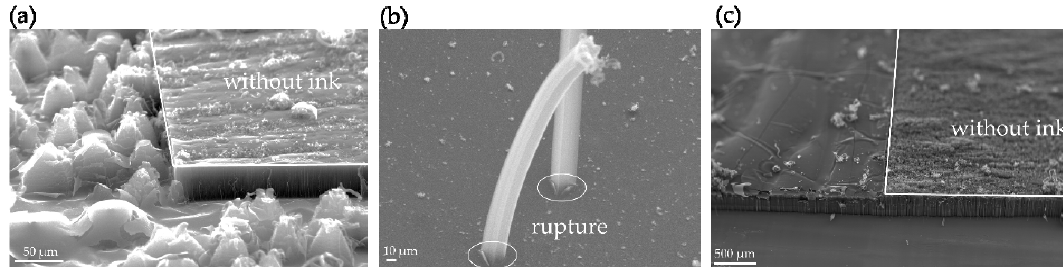
Figure 3. ( a ) A film layer forms on ink-coated areas of the sample following CNT synthesis; the resulting morphology contrasts to the areas without ink. ( b ) Nanotubes grow under the film layer, rupture its surface, and continue growing upward. ( c ) Following synthesis, the area of the sample coated in ink is elevated by a CNT forest growing underneath it.